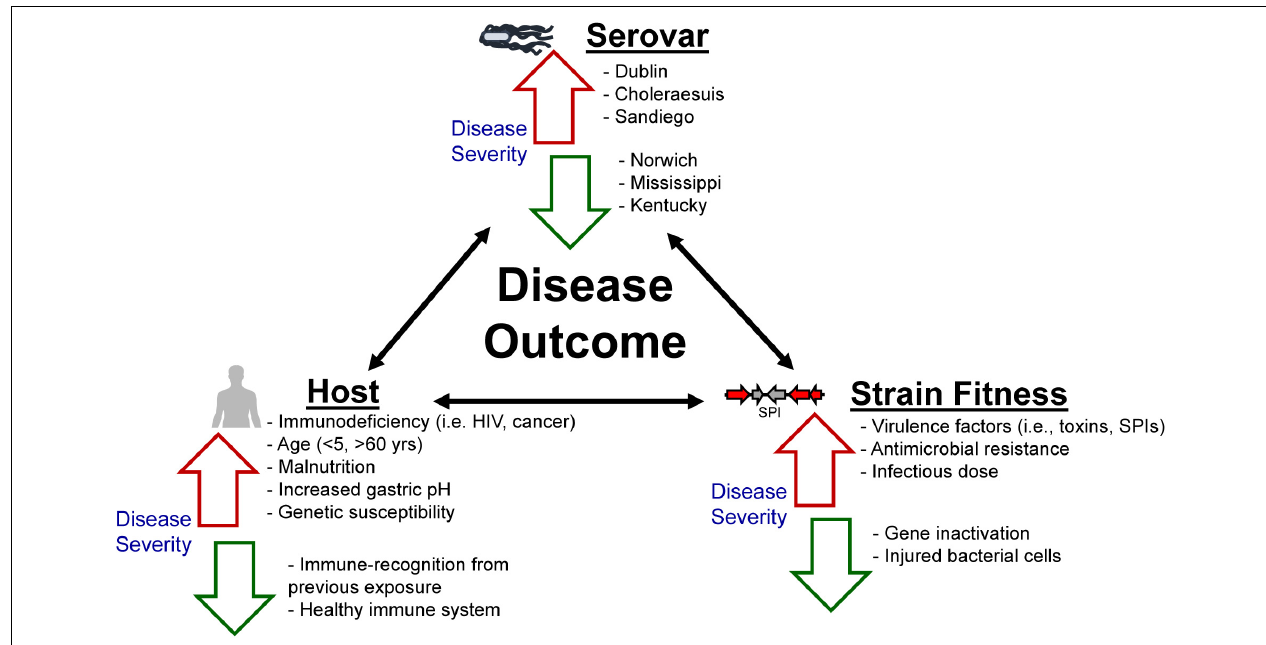
FIGURE 2 | Not all nontyphoidal salmonellosis infections are alike. The morbidity and mortality associated with nontyphoidal salmonellosis exists as an interplay between the host’s immune response as well as the overall fitness of the serovar/strain. Factors listed adjacent to red arrows have been previously established as contributing to increased disease severity, whereas factors listed adjacent to green arrows are associated with a decrease in disease severity.